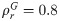
Model of foraging under predation risk.(A) The animal can either remain safely in its refuge or forage outside in a ‘patch’ location. The payoff for foraging depends on the habitat quality, which varies between good (G) and bad (B) states with transition rates (γGB, γBG), and whether a predator is absent (A) or present (P), as determined by transition rates (γAP, γPA). Grey boxes indicate that the values of the predator and habitat quality variables are hidden, i.e., are not directly observed but have to be inferred by the animal. Different actions are available to the animal depending on its current location. (B) Examples of the evolution of the belief that the habitat is good, βQ(G). Here, the environment switches from good to bad after 60s. For most actions, uncertainty will simply increase over time, and for γGB = γBG, will tend to 0.5 (dashed line). If the animal chooses to feed, its rate of encounter with rich patches (black points) provides information about current habitat quality (solid line). (C) Examples of the evolution of the belief that a predator is present, βD(P). Here, a predator enters and remains in the environment at 60s. If the animal is in the refuge and selects rest, there is no information about the state of predation, and uncertainty increases over time (again to βD(P) = 0.5; long dashed line). For most of the other activities, indirect cues oi (black points) are freely available, which provide some information about the state of predation (short dashed line). For assess, both indirect cues oi and direct cues od (red points) are available; the latter provide more reliable information about whether a predator is present or absent (solid line). Parameters: γGB = γBG = 0.01, ρrG=0.8, ρrB=0.2; γAP = γPA = 0.1, λoi-=λod-=0.1, λoi+=0.5, λod+=0.9.